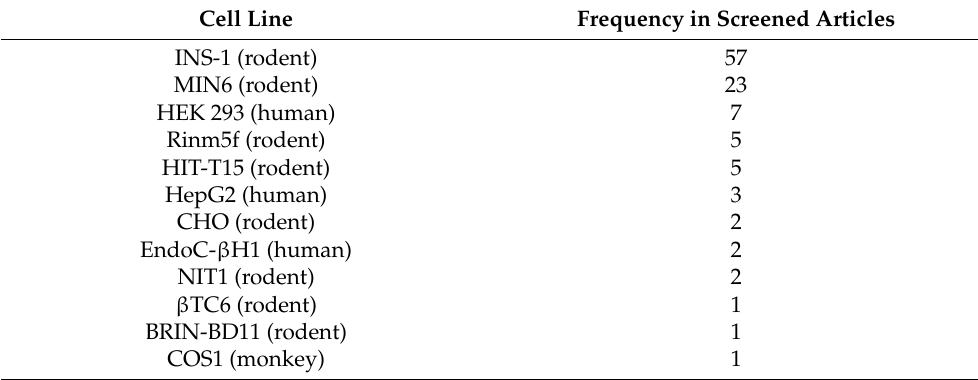
Table 4. Frequency of cell culture models used in screened literature ( n = 109). Insulinoma (INS-1).